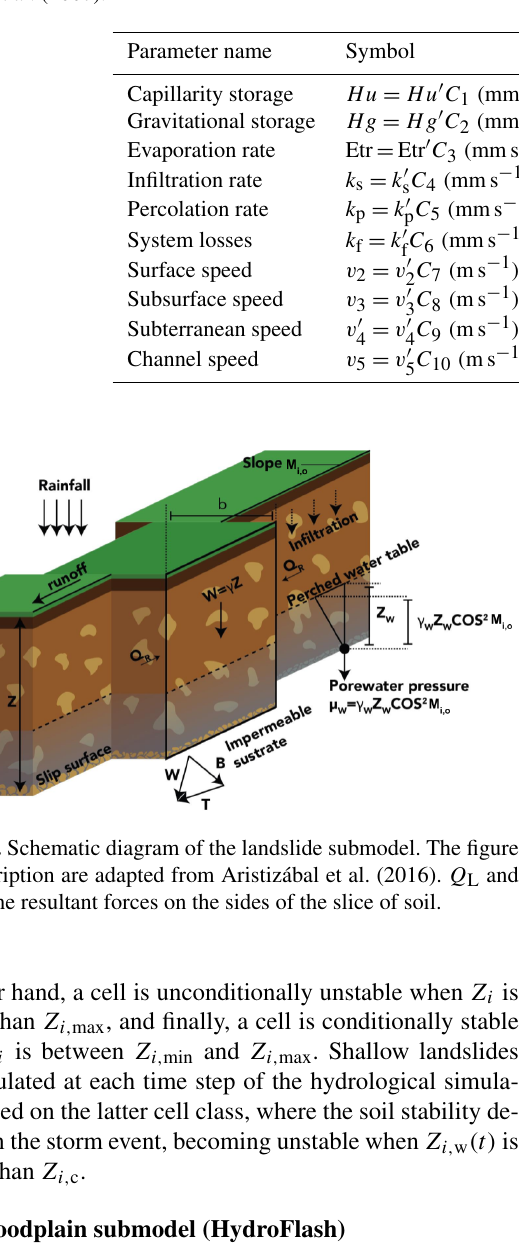
Table 3. TETIS model parameters. Primed variables correspond to values prior to calibration. Values for the parameters with a scalar factor of 1 are left uncalibrated. Parameters C 1 to C 6 are not presented in the explanation of the model. C 1 modulates the maximum capillary storage and C 2 the maximum gravitational storage. C 3 to C 5 modulate evaporation, infiltration, and percolation rates, respectively. C 6 is assumed to be zero, as this variable determines the subterranean system losses. More detail about the calibration parameters is presented in Francés et al. (2007).